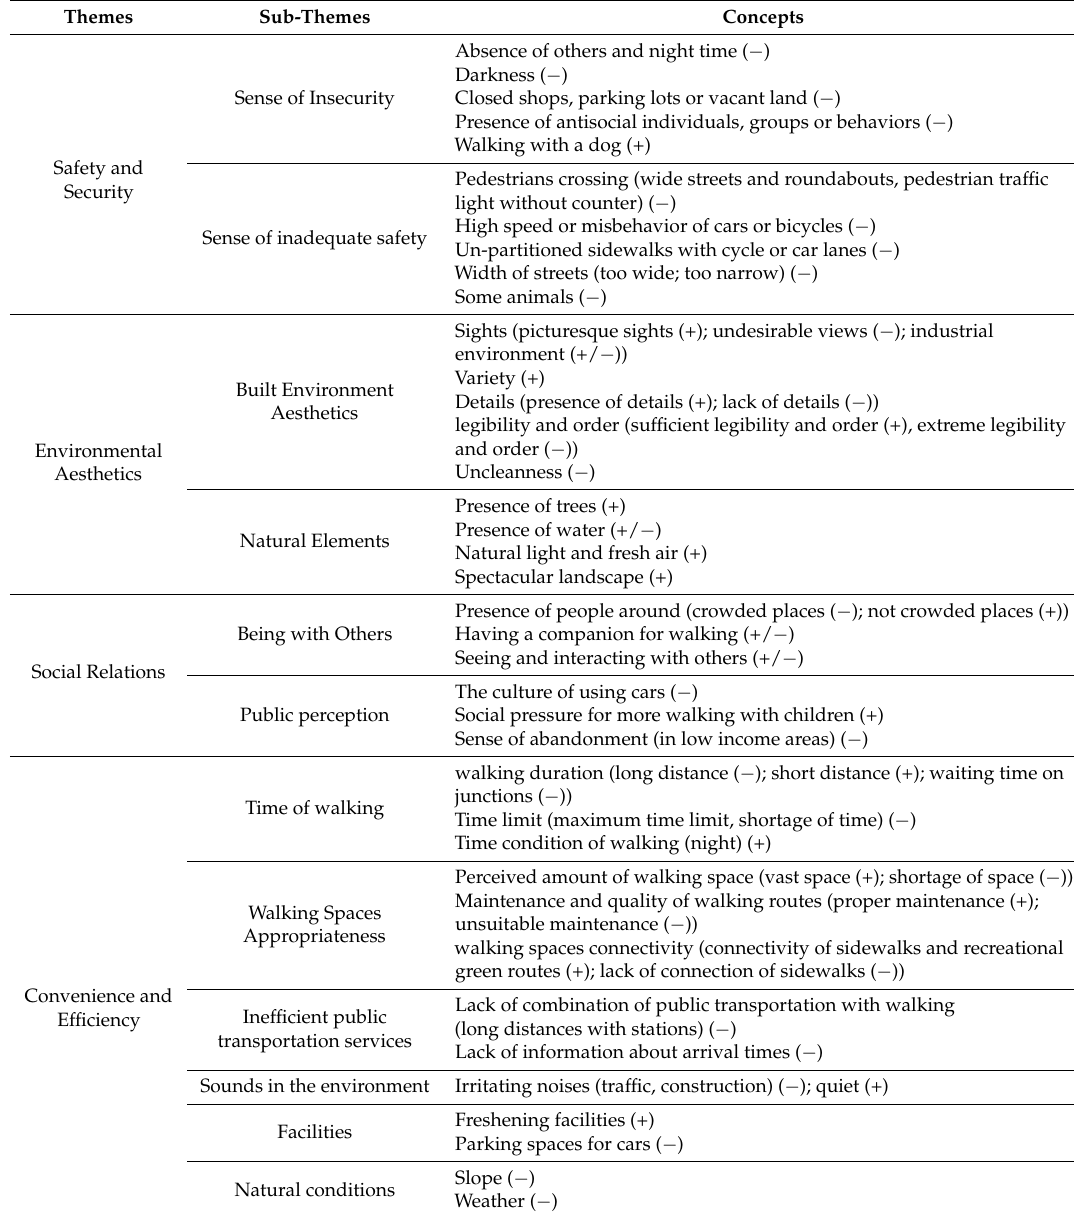
Table 3. Environmental factors which influenced the walking experience in three levels of themes, sub-themes and concepts (plus or minus signs refer to positive or negative influence on